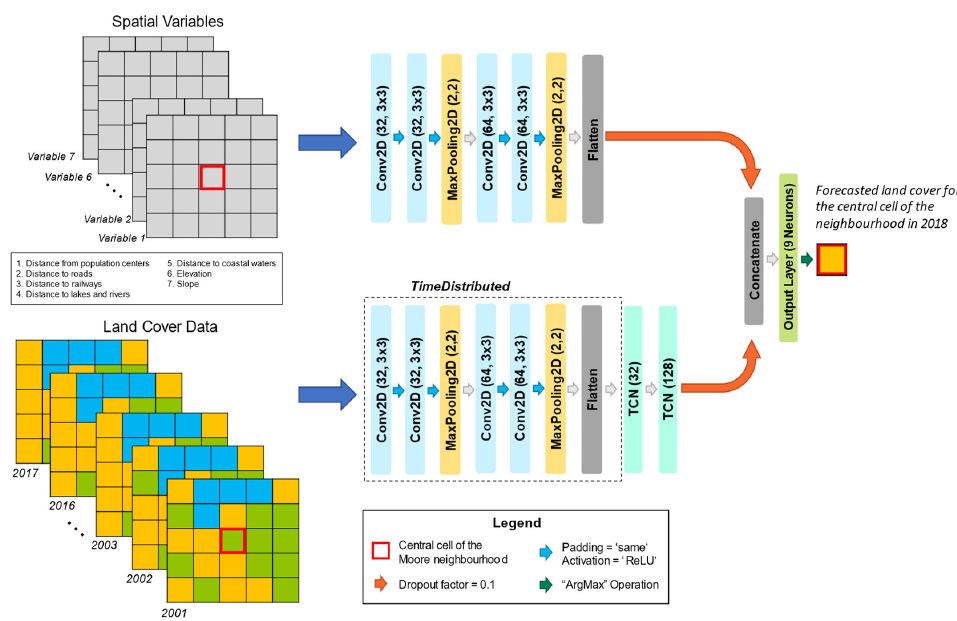
Figure 4. Configuration for training a multi-branch CNN–TCN model accepting the spatiotemporal LC data sequences and static spatial variables with a 5 × 5 Moore neighborhood.